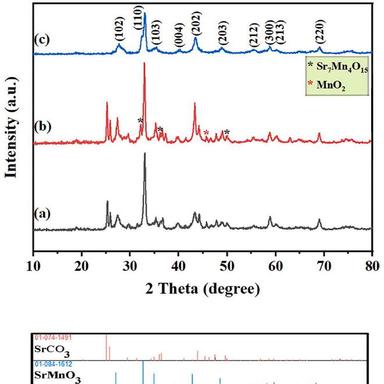
XRD patterns of: (a) S1, (b) S2 and (c) S3.